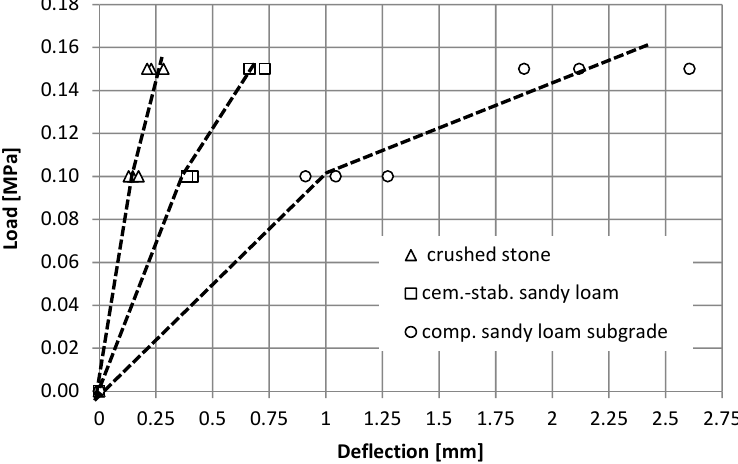
Figure 5. Material characteristics of the tested pavements depending on the load value (final cycle). The recorded displacement results were used in the further part of the work to identify the values of dynamic equivalent moduli ( Evd ) of the examined layer systems. Figure 6 shows the values of dynamic moduli determined for the initial and final load cycles at different load values. The dynamic modulus Evd was calculated on the basis of the measured values of displacements y i , depending on the value of the load σ i : Evd i = π × (1 − ν 2 ) × σ i × a /2 × y i ,